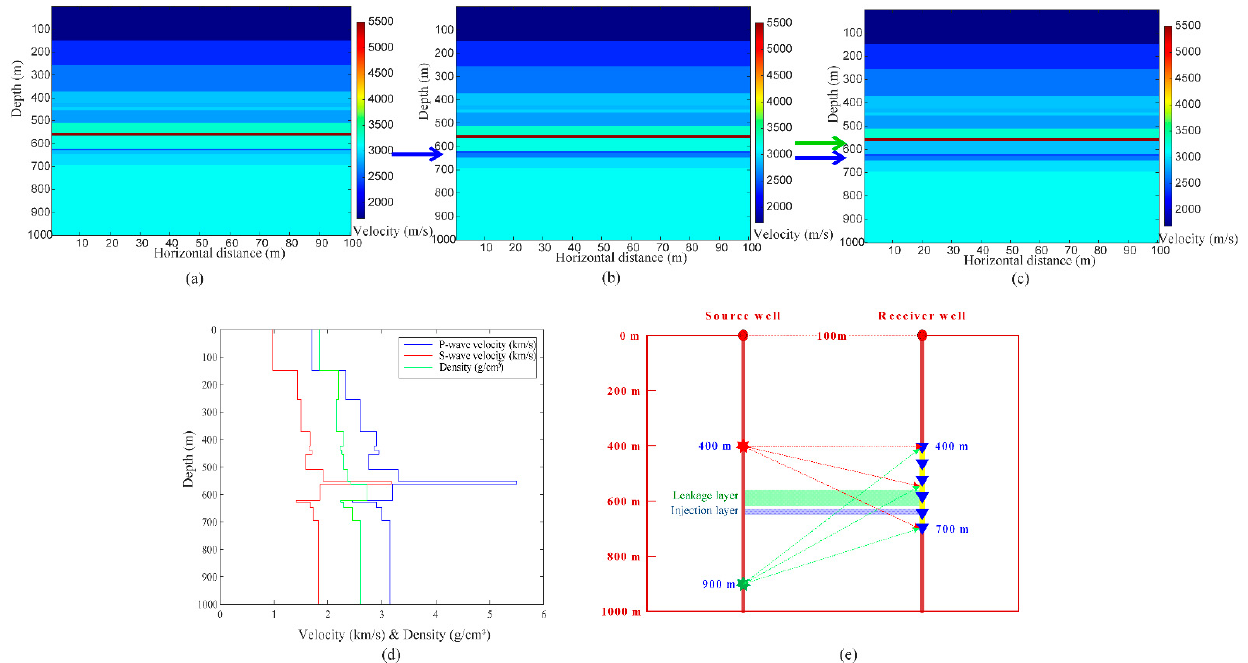
Figure 1. ( a – c ) The P wave velocity models for the baseline survey, first-repeat survey, and second-repeat survey, respectively. The injection and leakage layers are indicated by blue arrows and a green arrow, respectively. ( d ) The P wave velocity profile, S wave velocity profile, and density profile used for generating the synthetic elastic cross-well datasets. ( e ) The sketch shows the acquisition geometry.